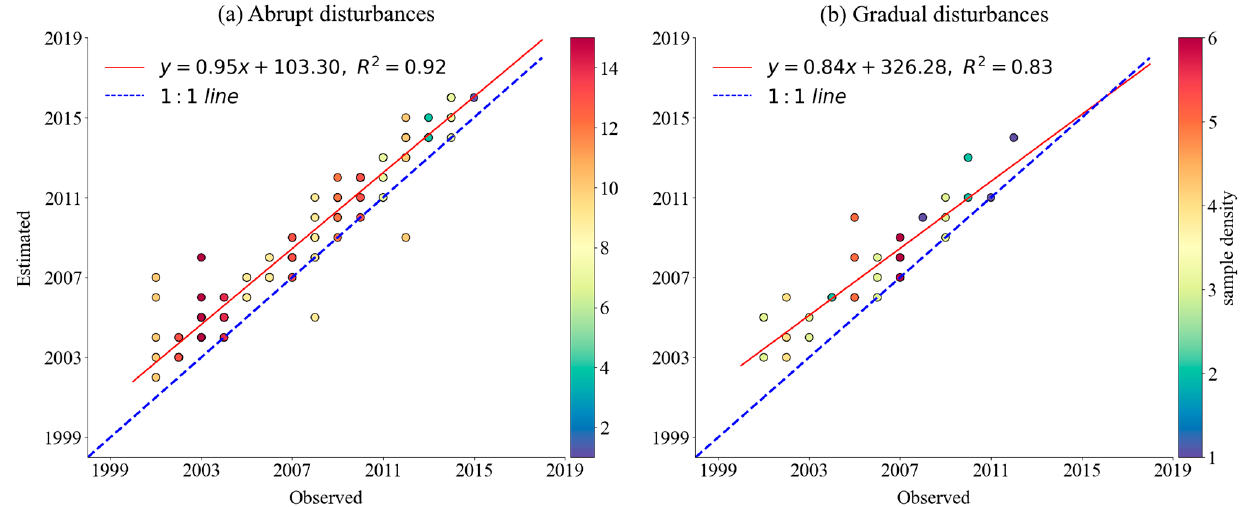
Figure 6. Scatter plots and linear fits of observed and estimated years of disturbances: ( a ) abrupt disturbances and ( b ) gradual disturbances.